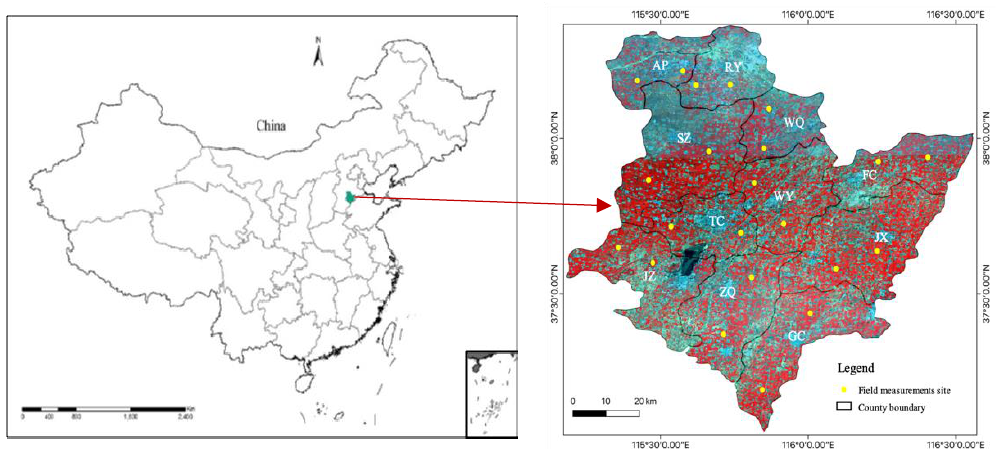
Figure 1. The location of the study area and field observation sites (yellow dots) of winter wheat in 2017.